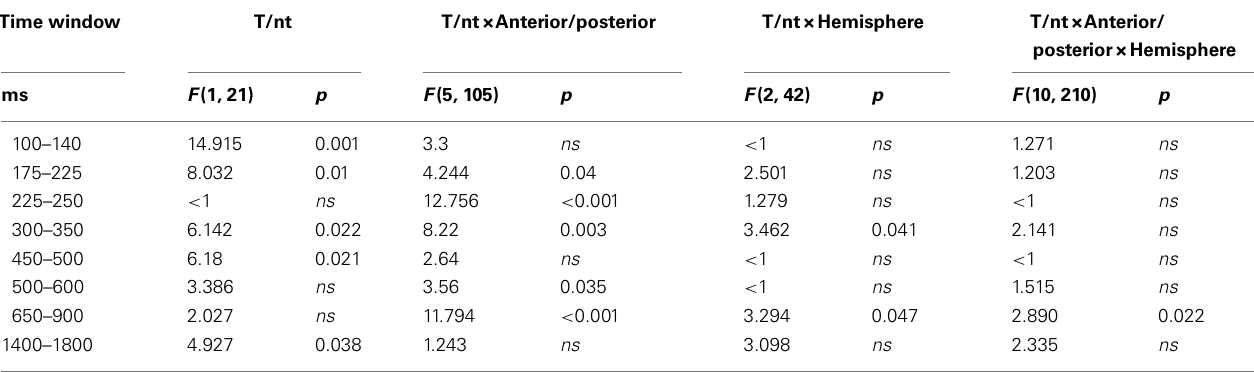
Table 2 | Results of the overallANOVAs comparing ERPs to think versus no-think conditions in the selected time